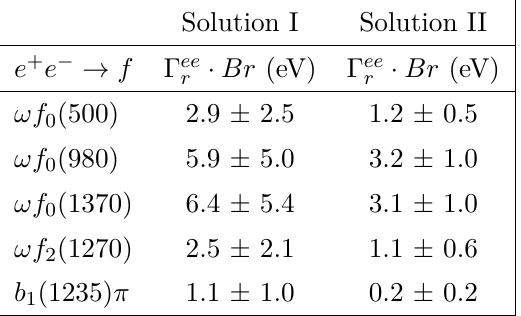
Table 10 . Γ ee · Br values from the simultaneous fit to the cross sections for the five intermediate r modes, where the uncertainties are statistical only.